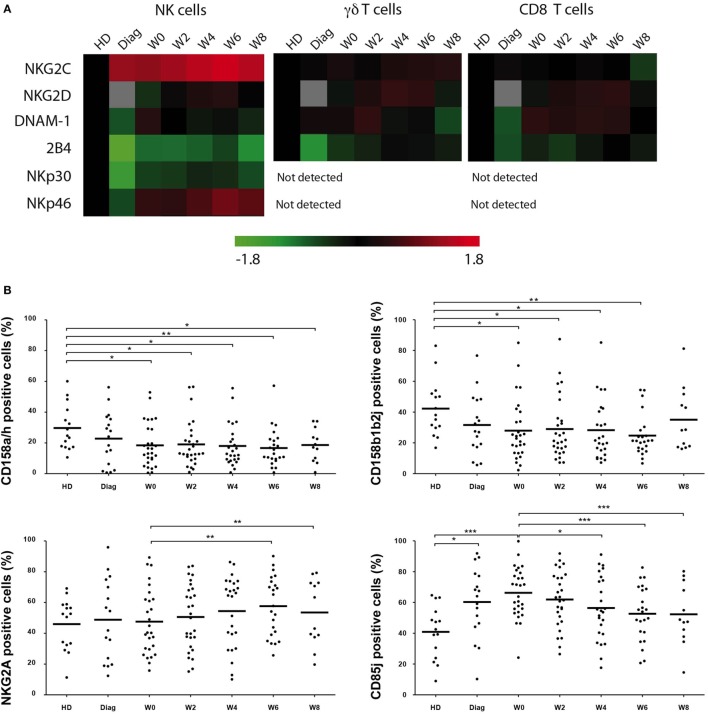
Kinetics of activating and inhibitory receptor expression. (A). Global view of expression of activating receptors was measured by flow cytometry on NK, γδ T, and CD8+ αβ T cells at the indicated time points. MFI (unimodal expression) and percentage of positive cells (bimodal expression) were normalized and hierarchically clusterized with Tmev software. Comparison with healthy donors (HDs) was performed, and data are represented with colors reflecting higher (red) or lower (green) expression compared to HDs. Gray squares correspond to non-determined values. (B). Expression of CD158a/h, CD158b1/b2/j, NKG2A, and CD85j by NK cells from HD and patients at the indicated time points. Bars represent the median expression and when indicated a Kruskal–Wallis non-parametric test with Dunn’s posttest was performed to compute the P value for the comparisons (*P < 0.05, **P < 0.01, ***P < 0.001).